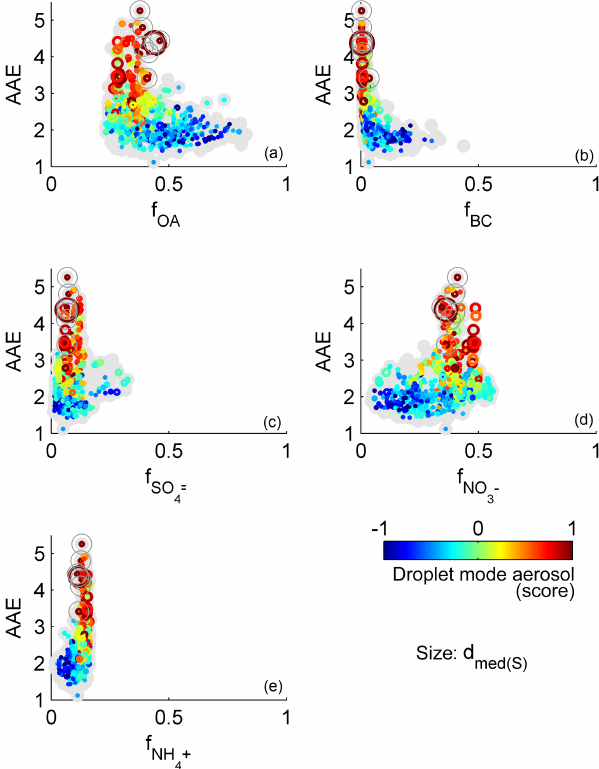
Figure 2. Physicochemical features of brown carbon. Absorption Ångström exponent at 467–660nm (AAE) plotted against mass fractions ( f x ) of (a) organic aerosol (OA), (b) black carbon (BC), (c) sulfate (SO 2 − ), (d) nitrate (NO − ), and (e) ammonium (NH + ). 4 3 4 Grey markers show the longest available time series for AAE and f x , while marker color and size indicate data points for which the droplet-mode aerosol scores and d med (S) were available (Sect. 3). Data indicated by dark grey “o” show case study values illustrated in Fig.